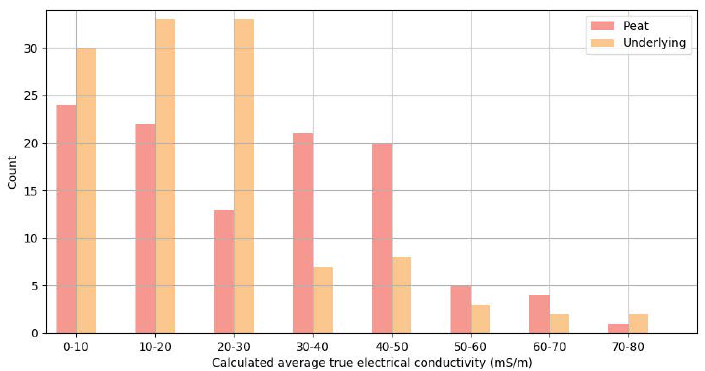
Figure 10. Distribution of the calculated average true electrical conductivity ( σ smooth ) estimates over the study area for peat and the underlying